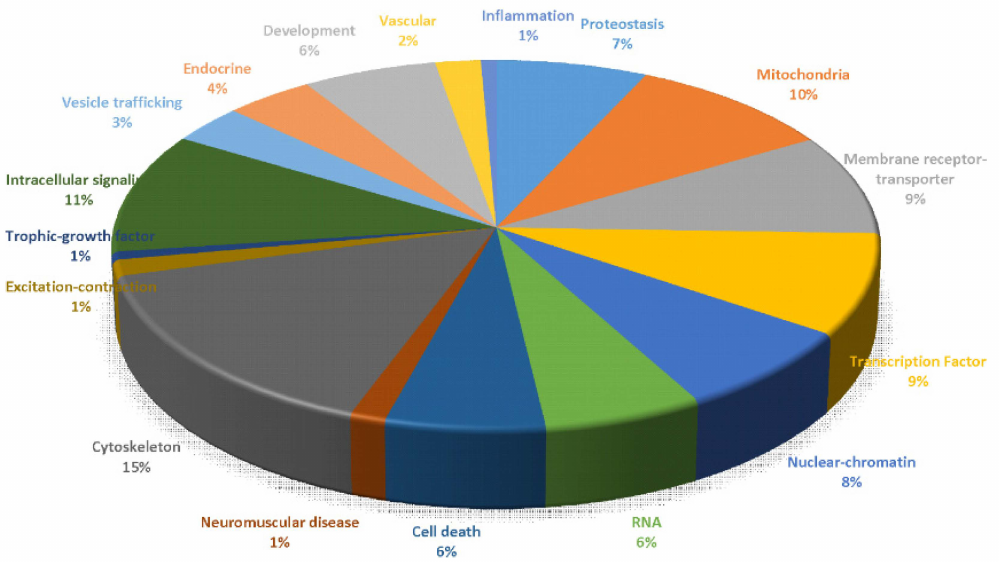
Figure 2. Global promoter CpG island microarray analysis in skeletal muscle (biceps femoris) of presymptomatic (12 months old) hSOD1 mus -G37R mice compared to age- and-sex-matched non-tg mice. Cut-off for significant hypermethylation in tg mice ( n = 3) versus age-matched non-tg mice ( n = 3) was a 2-fold difference. Triage of identified genes with significant hypermethylation into classes was based on known functions of their products. Representative genes assigned to the different categories are shown in Table